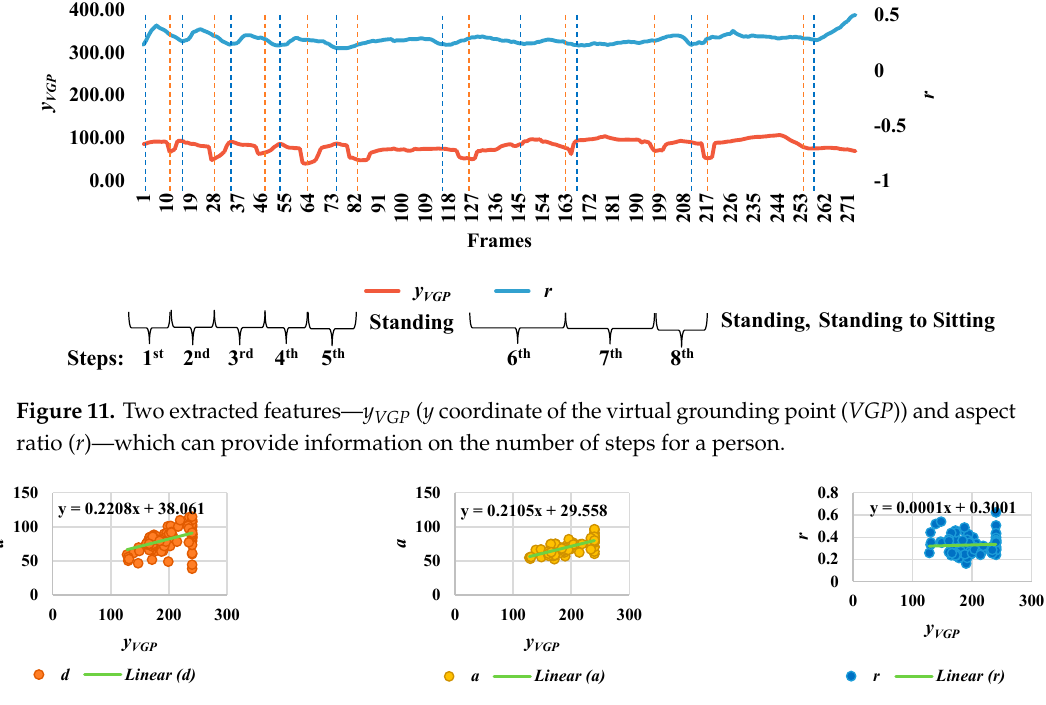
Figure 12. Analysis of camera calibration for all scenes.